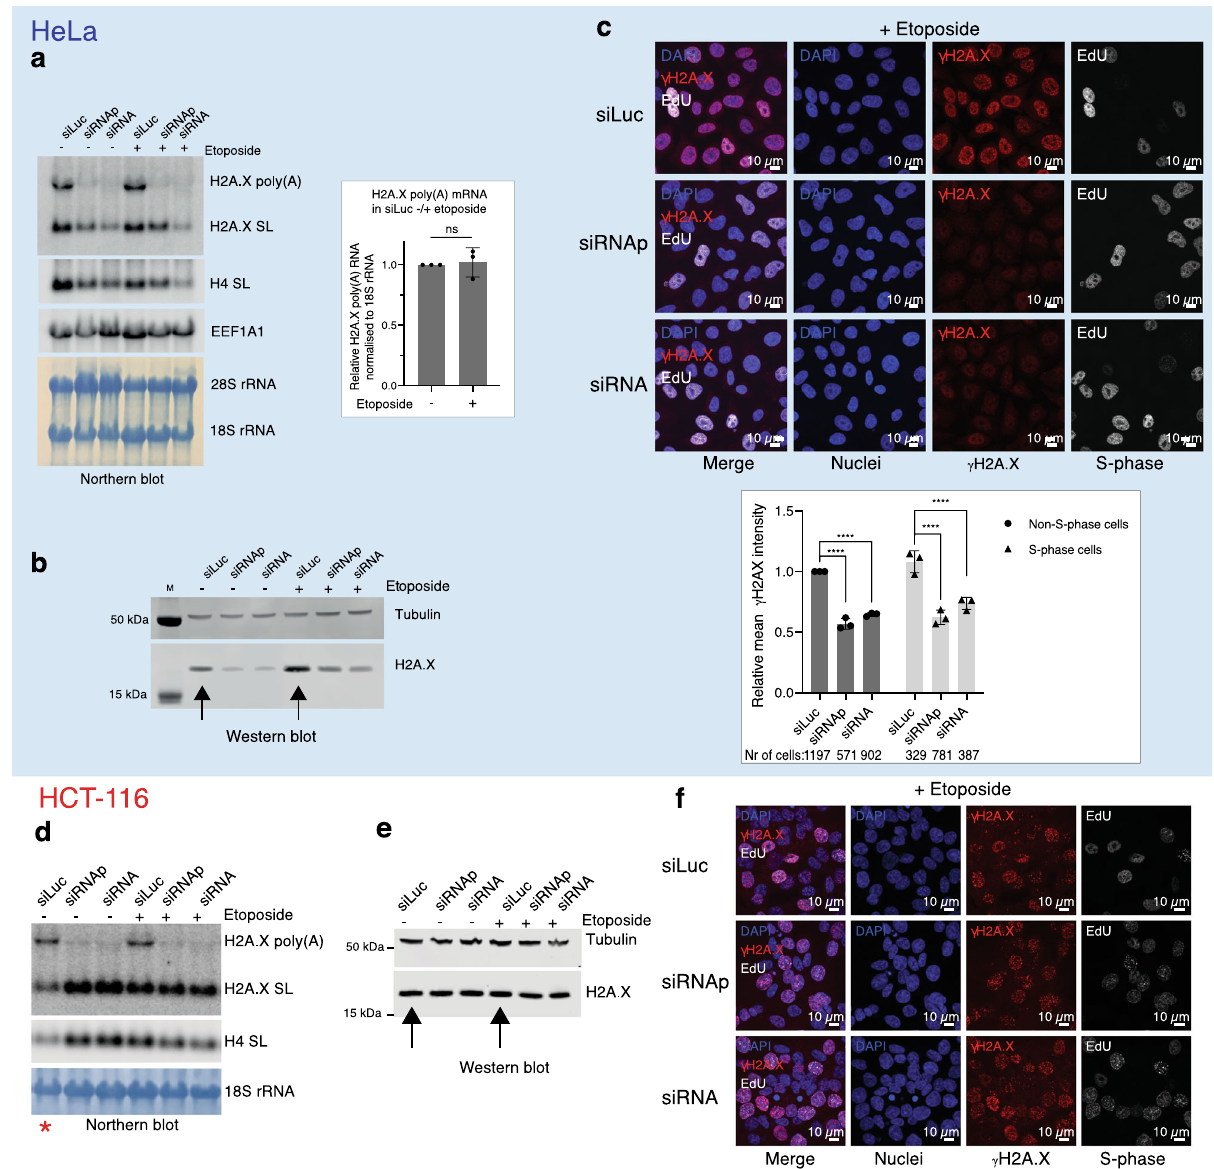
Fig. 6 Effects of H2A.X poly(A) mRNA depletion under DNA damage conditions. a H2A.X mRNA northern blot of total RNA from HeLa cells treated with siRNA for 72 hr (left panel). H4 SL: core H4 histone SL mRNA. EEF1A1 mRNA, 28S and 18S rRNA used as loading controls. Etoposide treatment (5 μ M) was performed for 2 hr before harvesting. Tubulin was used as loading control. H2A.X: total H2A.X protein. γ H2A.X: H2A.X phosphorylated at Ser139. M: protein size marker. H2A.X poly(A) mRNA quanti fi cation in siLuc without and with etoposide by real-time PCR (right panel). Mean ± SD presented for n = 3 independent experiments, paired Student ’ s t -test, ns: not signi fi cant P -value >0.05. b Western blot of total protein extracts from HeLa cells as indicated. Etoposide treatment (5 μ M) was performed for 2 hr before harvesting. Black arrows: total H2A.X protein in siLuc control cells before and after etoposide treatment. c IF of HeLa cells with etoposide treatment (5 μ M for 2 hr before harvesting). Blue: DAPI (nuclei). Red: γ H2A.X. White: EdU (S-phase cells). Quanti fi cation of nuclear γ H2A.X signal in non-S-phase (black bars) and S-phase cells (grey bars) (bottom). Mean ± SD presented for n = 3 independent experiments, two-way ANOVA with Tukey ’ s multiple comparisons test. **** P -value ≤ 0.0001 (left). d – f As in a – c , respectively, but for HCT-116 cells. The red asterisk indicates unequal loading in lane 1 of d